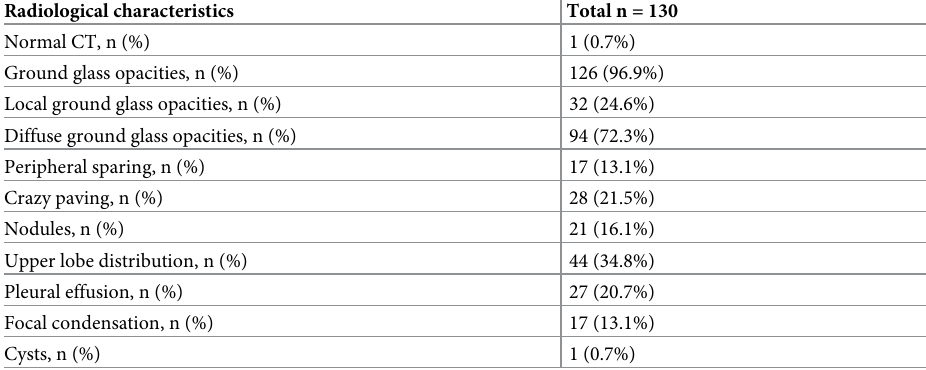
Table 2. Computed Tomography (CT)